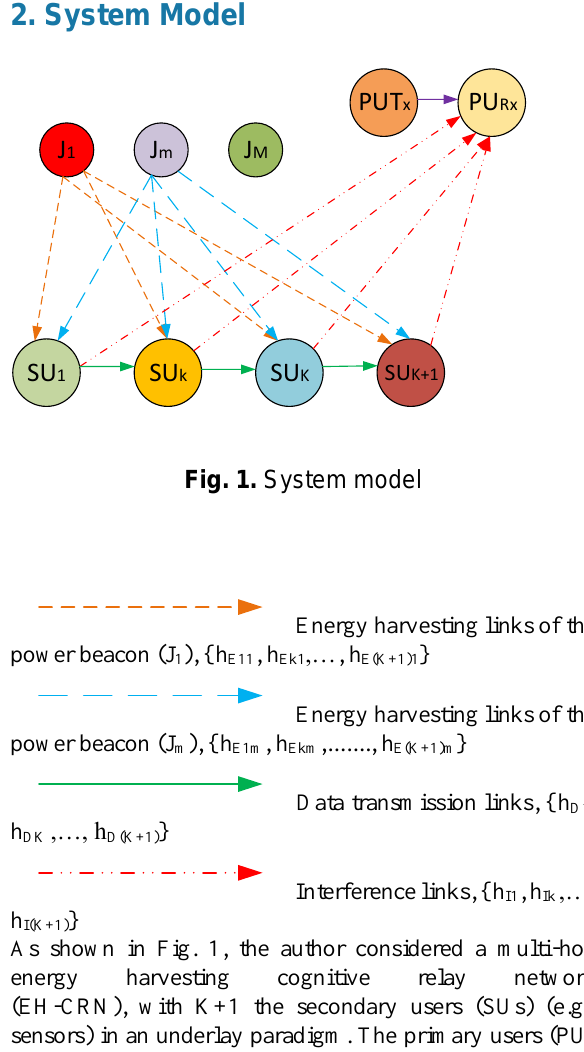
Data transmission links, {h D1